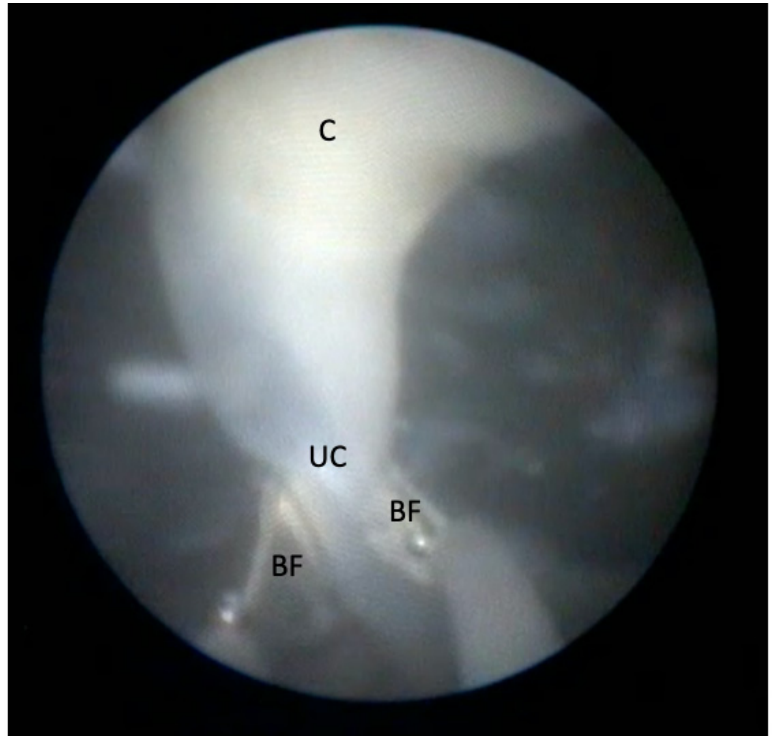
Figure 1. Occlusion of the umbilical cord (UC) with bipolar forceps (BF) at multiple levels. The level of the preceding coagulation (C) is depicted at 12 o’clock.